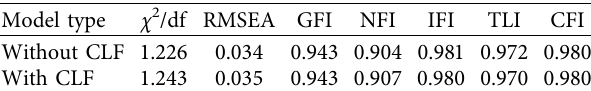
Table 3: Te result of the common latent factor test.